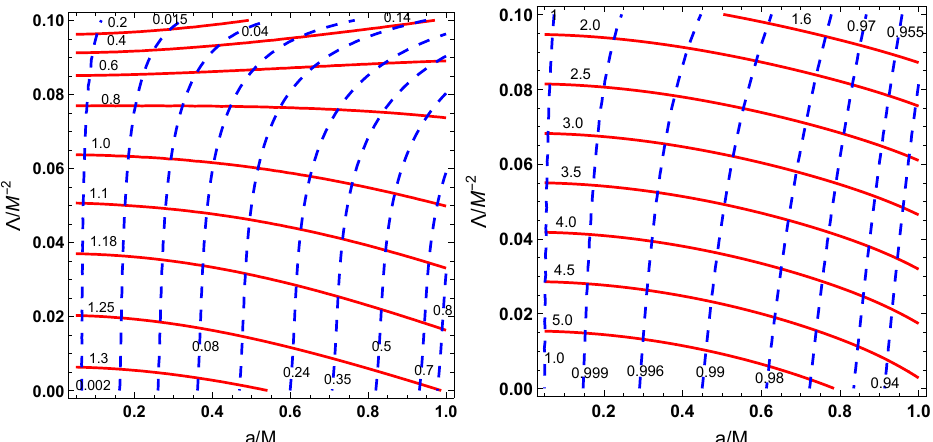
Figure 9. Contours for new Kerr–de Sitter black holes shadow observables, R s (red solid lines) and δ s (blue dashed lines) ( left ), A / M 2 (red solid lines) and D (blue dashed lines) ( right ) for a static observer at ( r o , θ o ) = ( 4 M ,90 ◦ ) . The contour intersection points uniquely determine the black hole